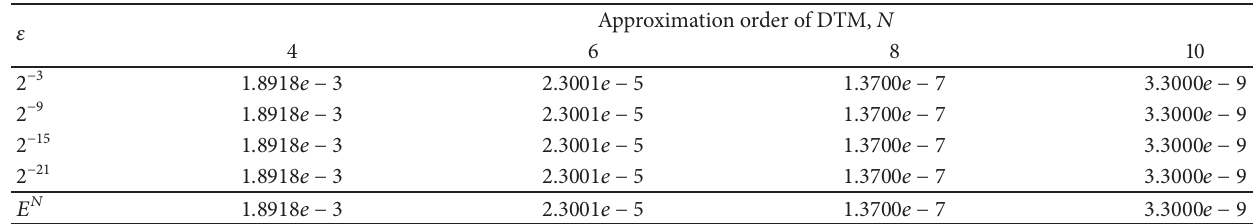
Table 6: Maximum pointwise errors 𝐸 𝑁 𝜀 and 𝐸 𝑁 for the solution 𝑦 1, ap of Example 3.